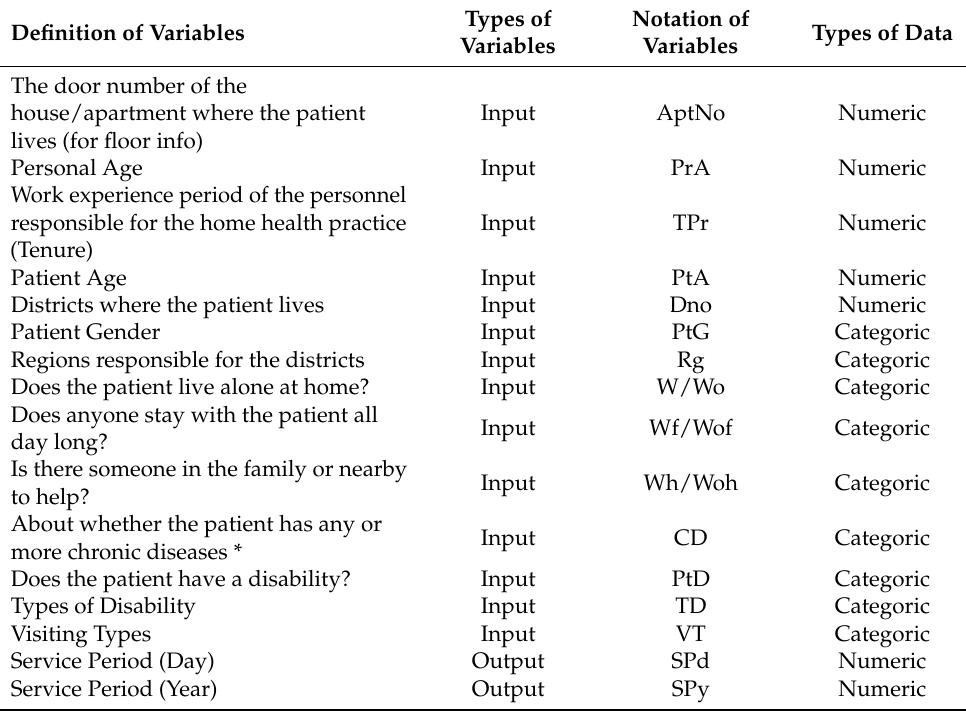
Table 1. Definition, type, notation, and data type information of dependent and independent